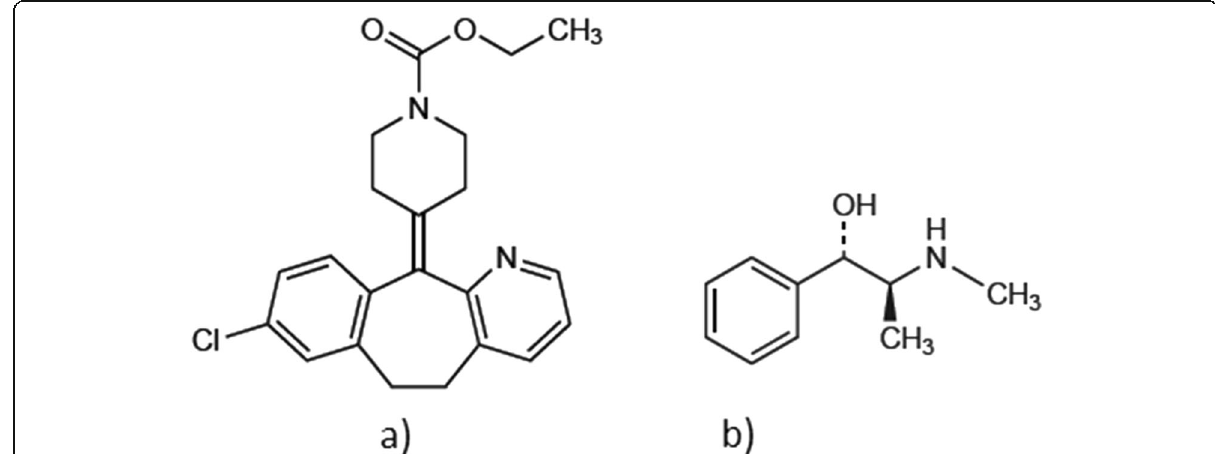
Fig. 1 Chemical structure of a loratadine and b